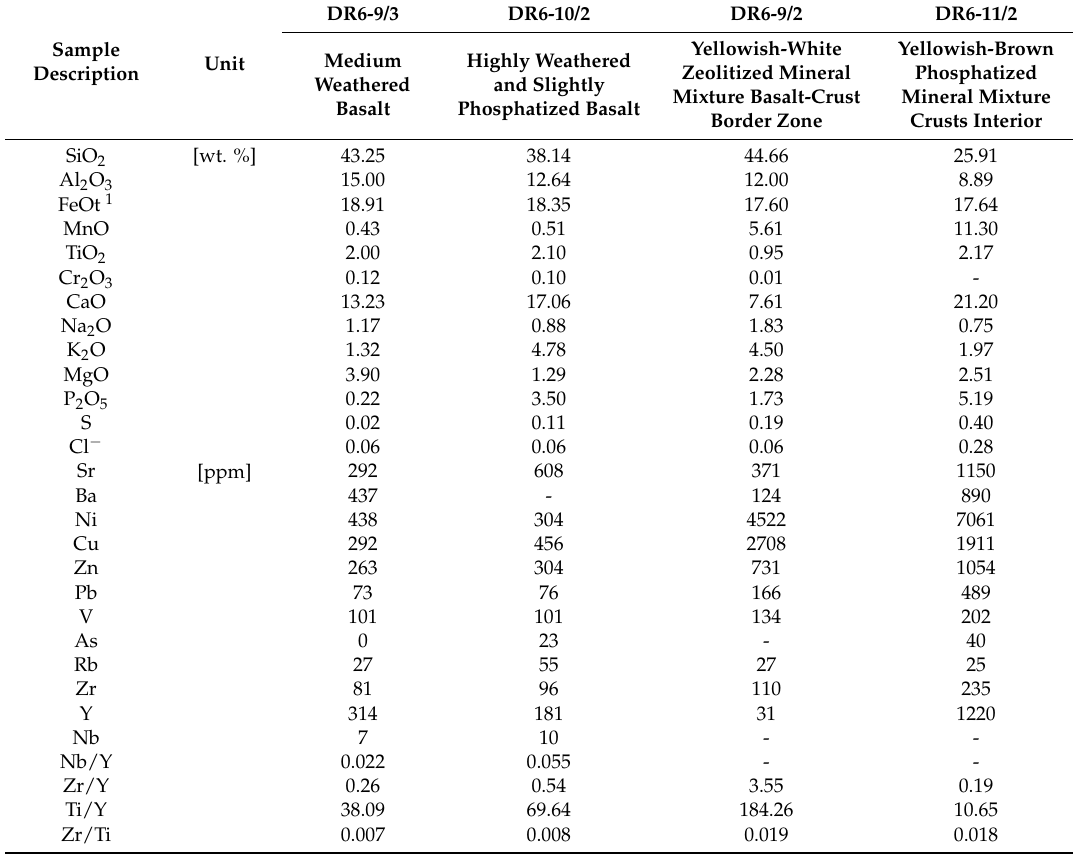
Table 2. EDXRF chemical results of the bulk samples from the